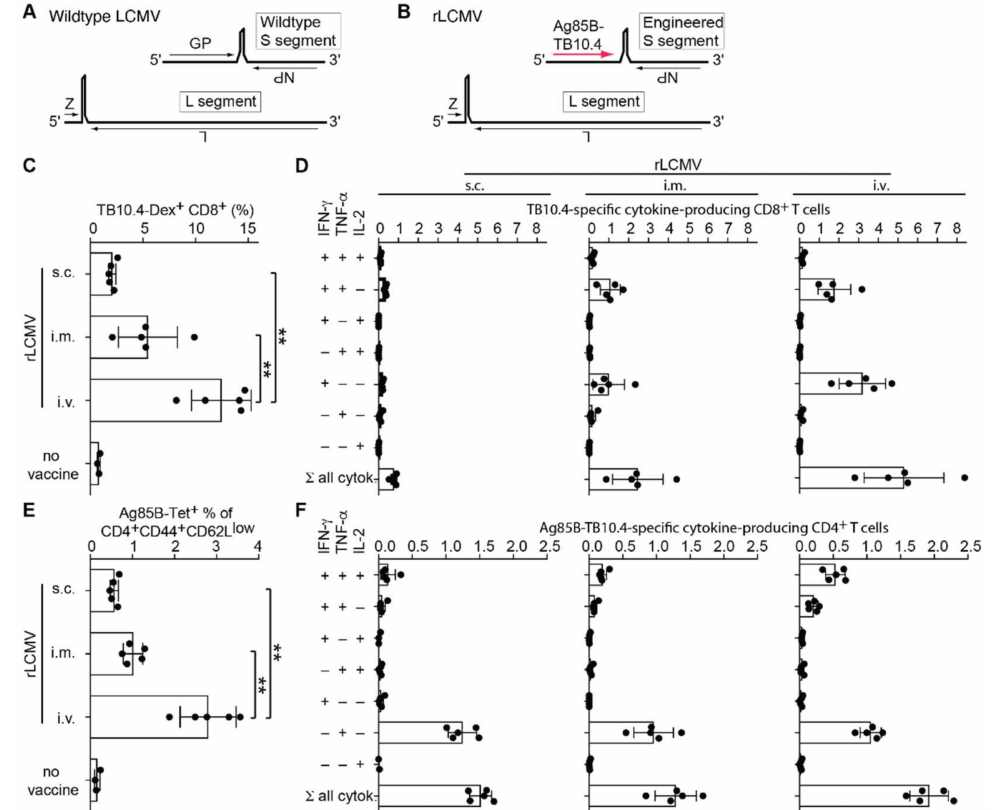
Figure 1. rLCMV elicits high frequencies of polyfunctional CD8 and CD4 T cells. ( A , B ): Schematic representation of the wildtype LCMV ( A ) and rLCMV vector ( B ) genomes. ( C – F ): We immunized C57BL/6 mice with 10 6 PFU of rLCMV either s.c., i.m., or i.v. Controls were left unimmunized (no vaccine, panels ( C , E ) only). After 28 days, we measured T cell responses to Ag85B-TB10.4 in the spleen. ( C ): TB10.4-dextramer-binding CD8 T cells. ( D ): TB10.4-specific cytokine-producing CD8 T cells. ( E ): Ag85B-tetramer-binding cells amongst activated (CD44 + CD62L low ) CD4 T cells. ( F ): Ag85B-TB10.4-specific cytokine-producing CD4 T cells. Bars represent the mean +/ − SD of